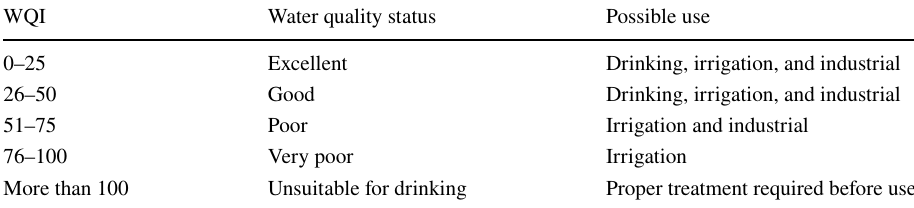
Table 5 WQI ranges, status, and possible use of the water sample (Brown et al.